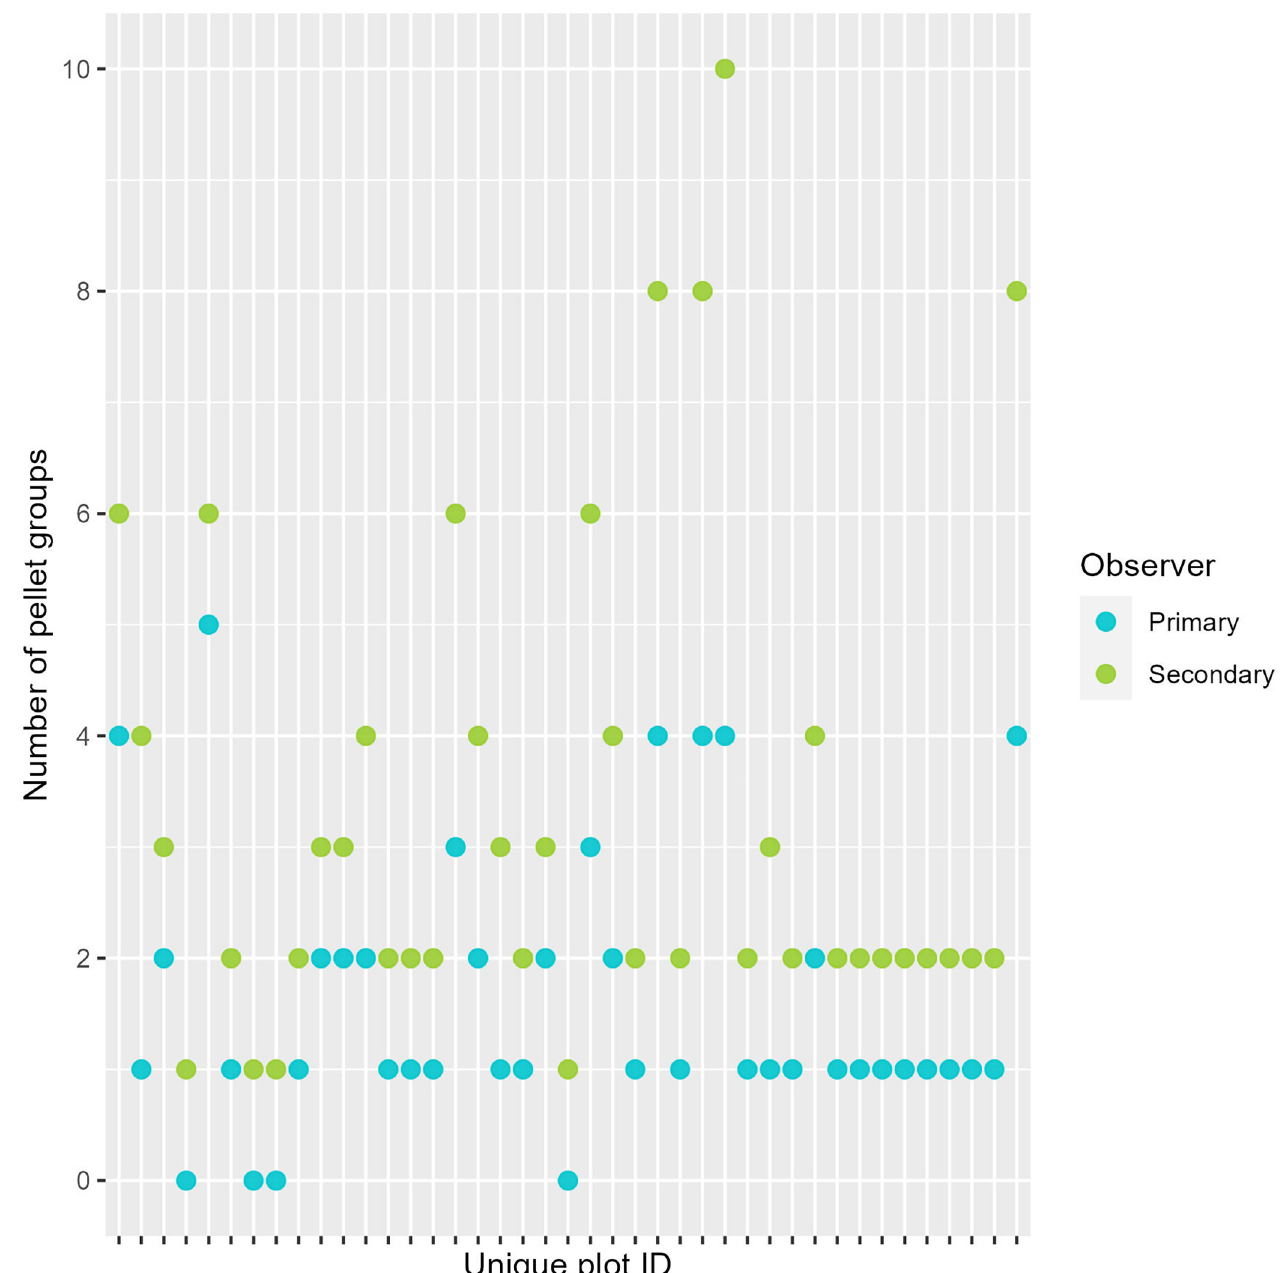
Fig 5. The differences in moose pellet group counts between primary and secondary observers for unique plots. Here, we visualized data only where counts between primary and secondary observers differed (82 plots). Data were subset from the full dataset (325 plots) and were collected in Norway (2019–2020).